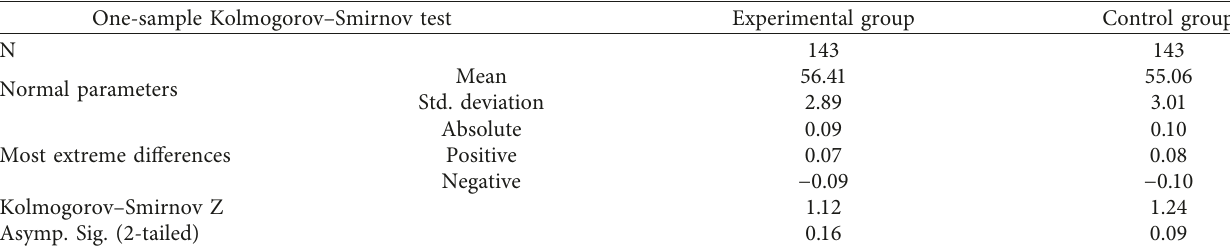
Table 2: Normality test.